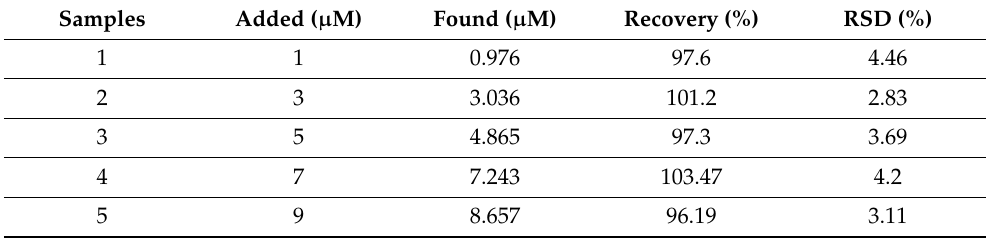
Table 2. Determination of SY in the beverage samples ( n = 5).